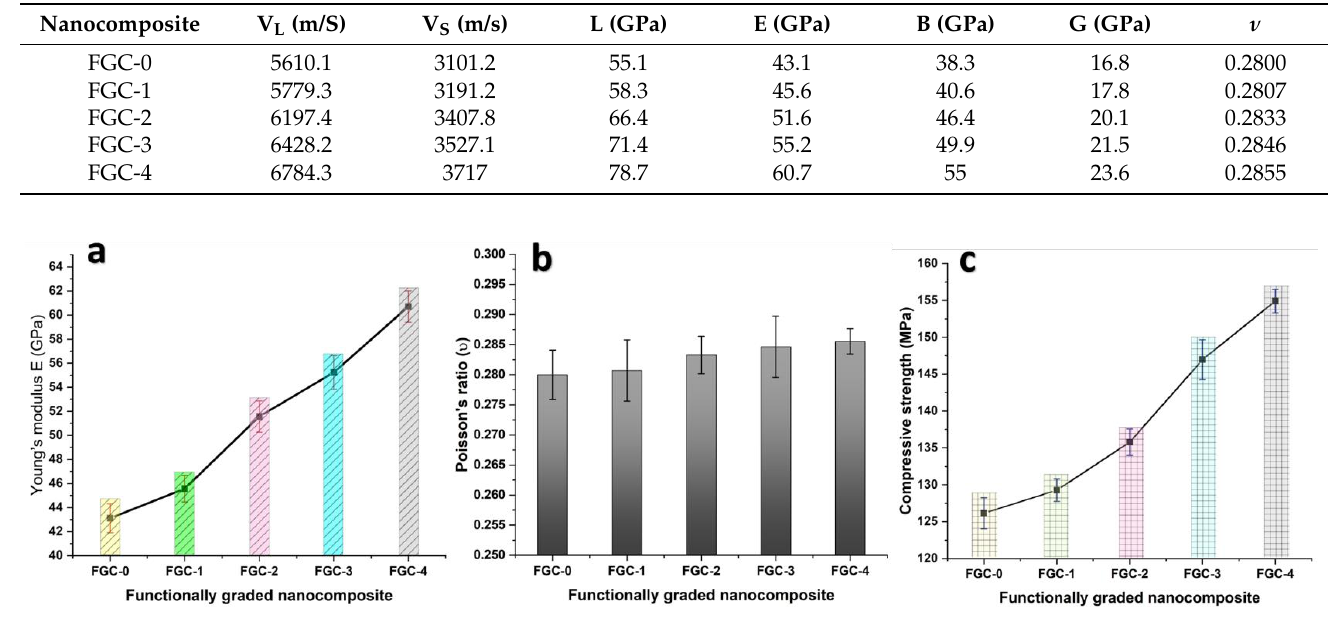
Figure 12. ( a ) Young’s modulus, ( b ) Poisson’s ratio as a representative of the elastic moduli, and ( c ) Compressive strength measured by non-destructive ultrasonic technique for all FGCs.